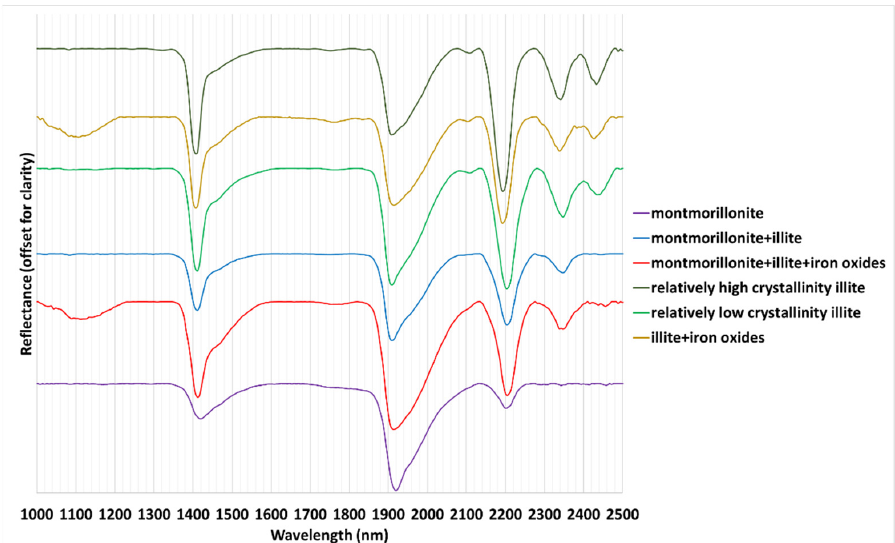
Figure 2. Hull removal SPECIM SWIR spectra of montmorillonite (purple), montmorillonite+illite+iron oxides (red), montmorillonite+illite (blue), low crystallinity illite (light green), illite+iron oxides (dark yellow), and high crystallinity illite (dark green) of the rock samples of the Kuh Panj area. From top down, the depth of water absorption depth at around 1900 nm is increasing compared to aluminum hydroxyl absorption depth.